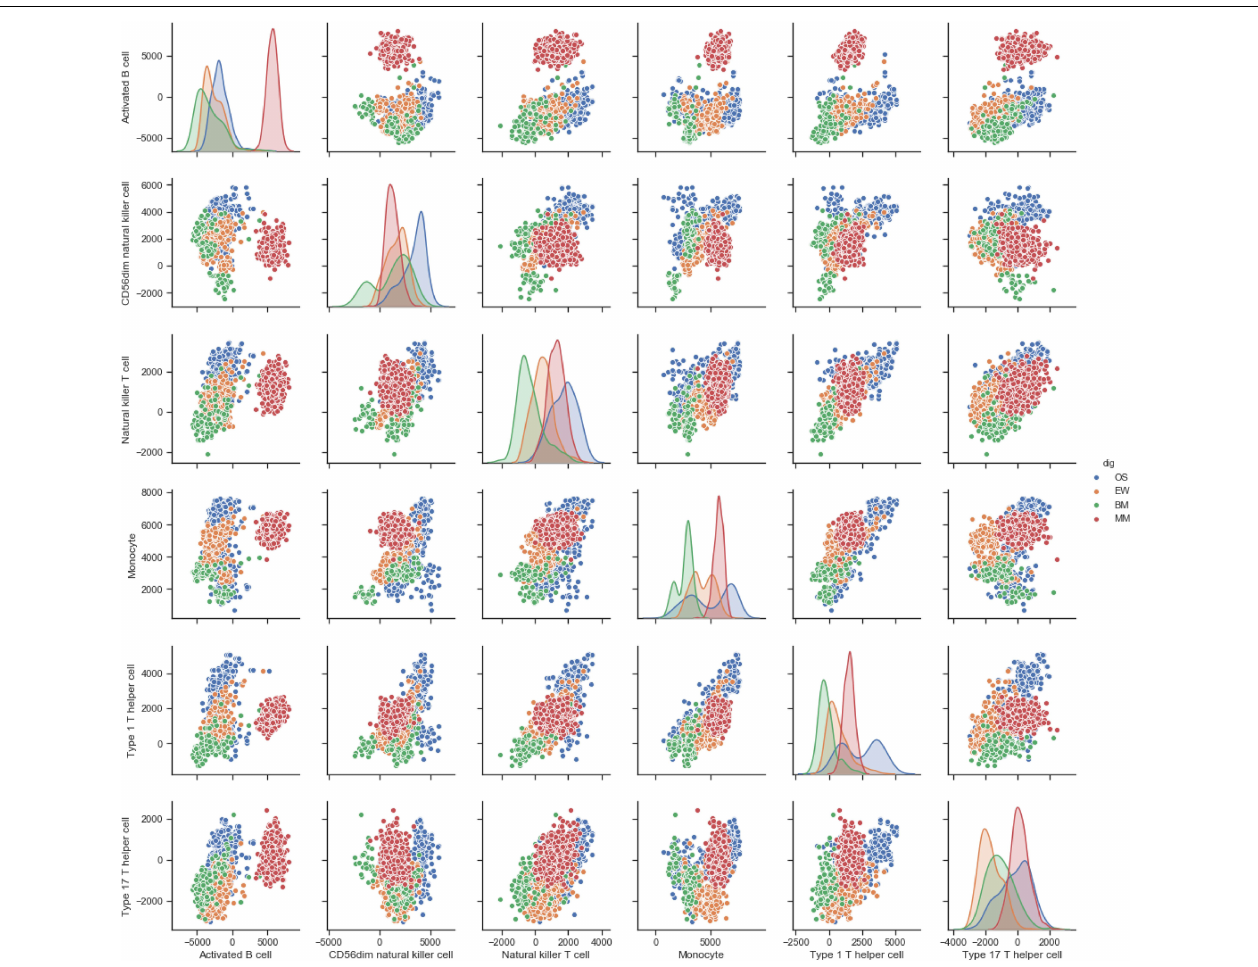
FIGURE 2 | Pair plot of ES score of each cell type across four diseases. The floor area diagram represents ES score distribution across four diseases; the dot plot represents the two-dimensional spatial distribution of each sample. Disease types are annotated by colors. MM, multiple myeloma; EW, Ewing’s sarcoma; BM, prostate cancer bone metastases; OS,